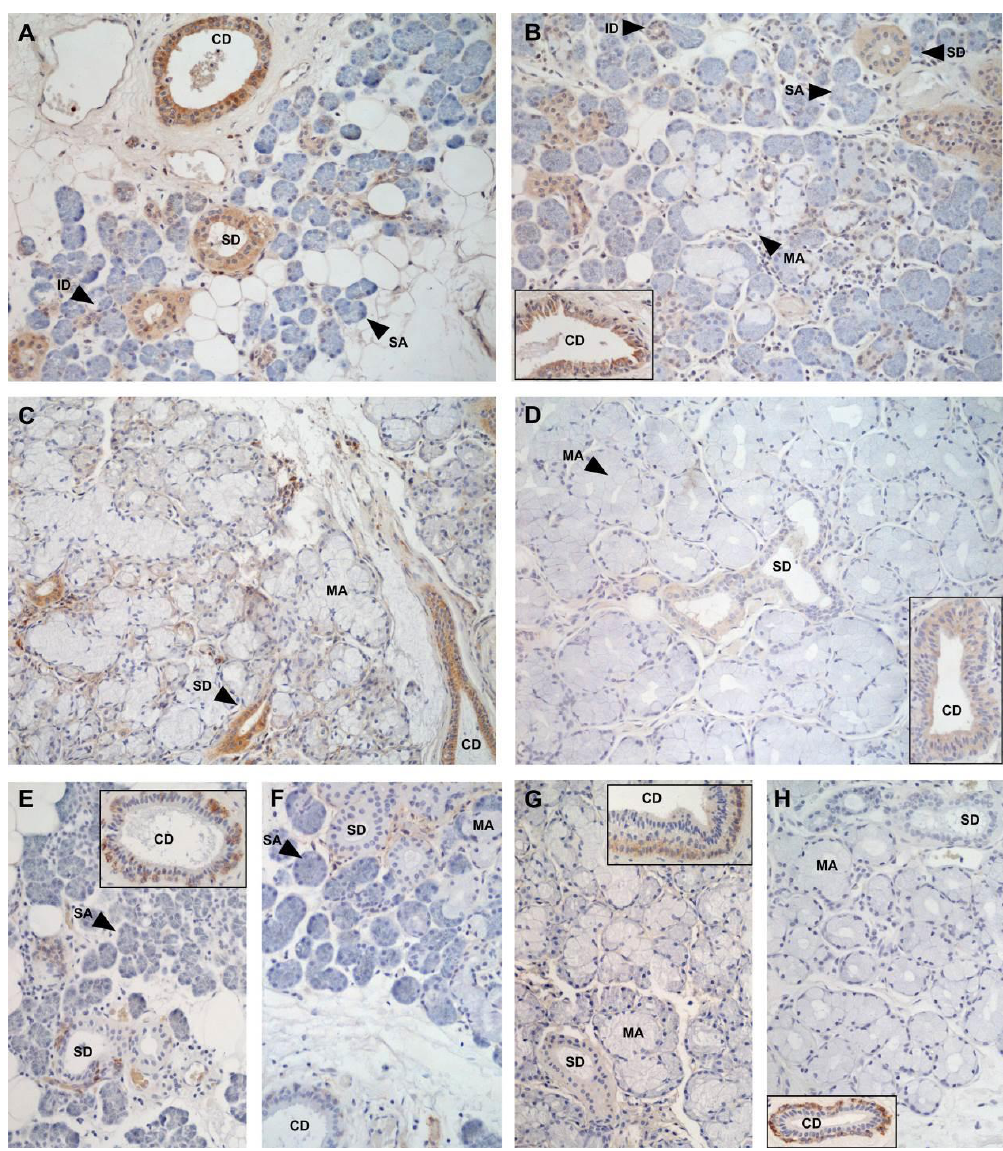
Figure 6. Immunohistological expression of TrkA ( A – D ), and p75 NTR ( E – H ) in salivary glands; ( A , E ) parotis; ( B , F ) submandibular gland; ( C , G ) sublingual gland; ( D , H ) labial glands. CD, collecting duct; ID, intercalated duct; MA, mucous acinus; SA, serous acinus; SD, striated duct. The brown color indicates positive staining. Counterstaining with hematoxylin (blue). Original magnification, 20 ×. With permission from ref. [7].